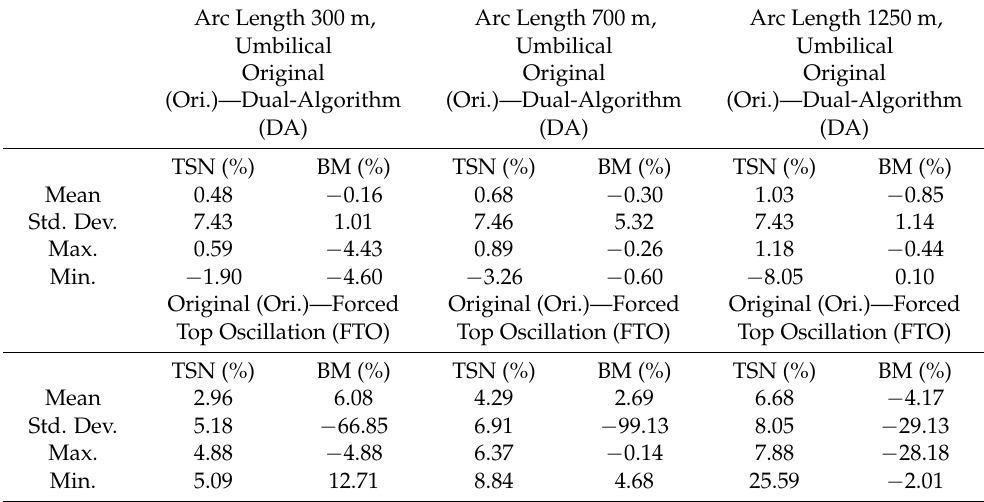
Table A7. Error Comparison: Original vs. Dual-Algorithm (DA) or FTO, 100-yr Storm, WD1000,